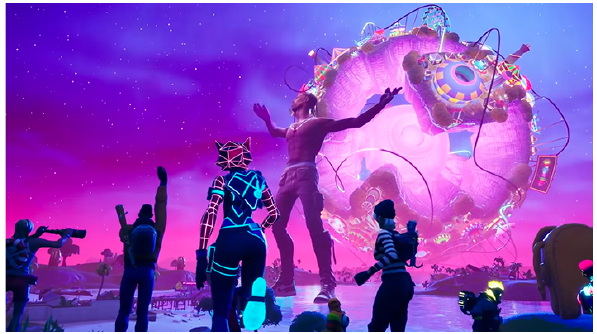
Figure 39: Travis Scott in Fortnite Metaverse